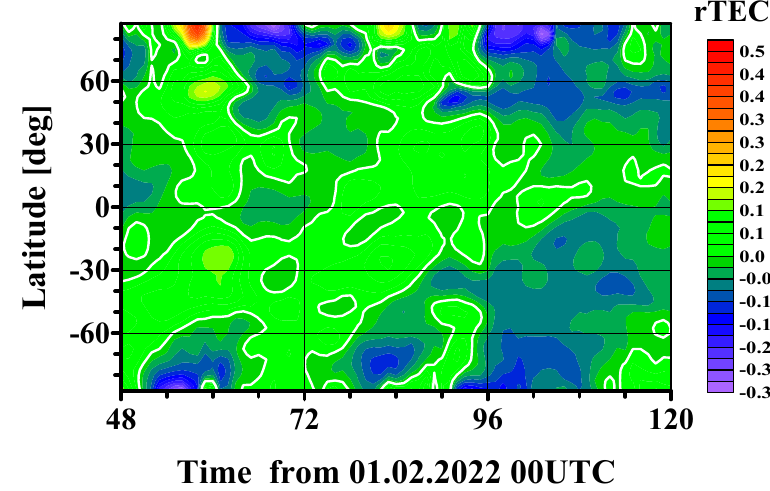
Figure 4. Zonal mean relative TEC by CODE from 3 March to 5 March.